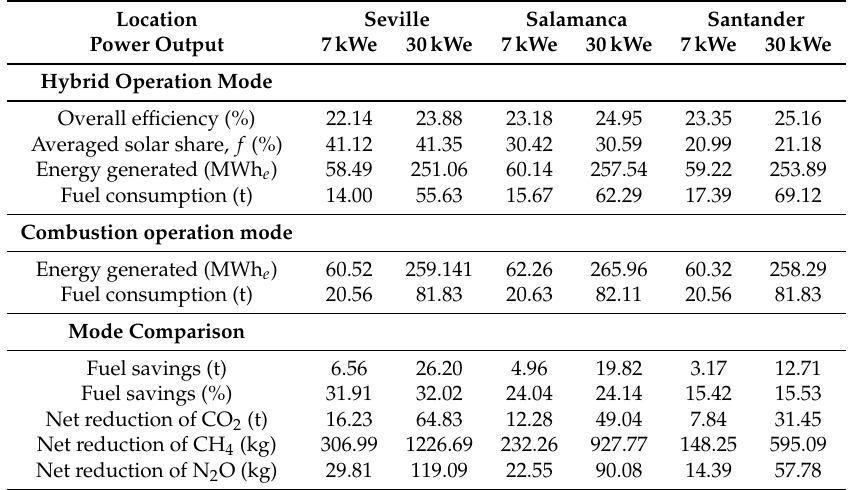
Table 3. Comparison of the annual results for different locations for hybrid and pure combustion